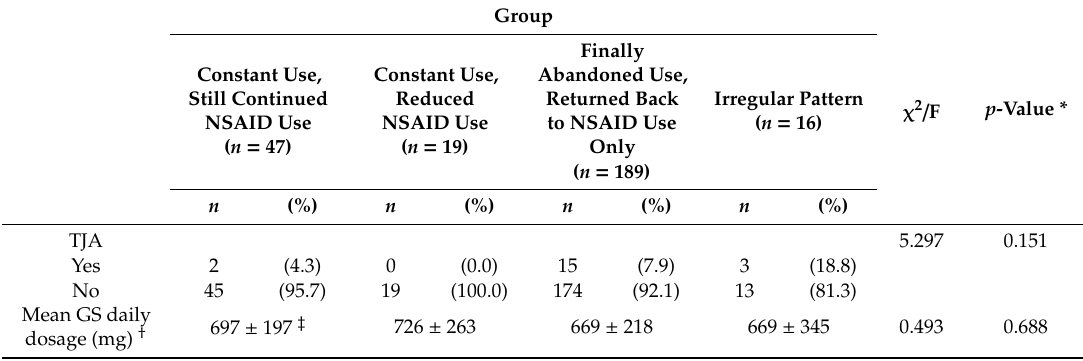
Table 6. TJA and mean dosage of glucosamine sulfate (GS) among four GS utilization patterns.